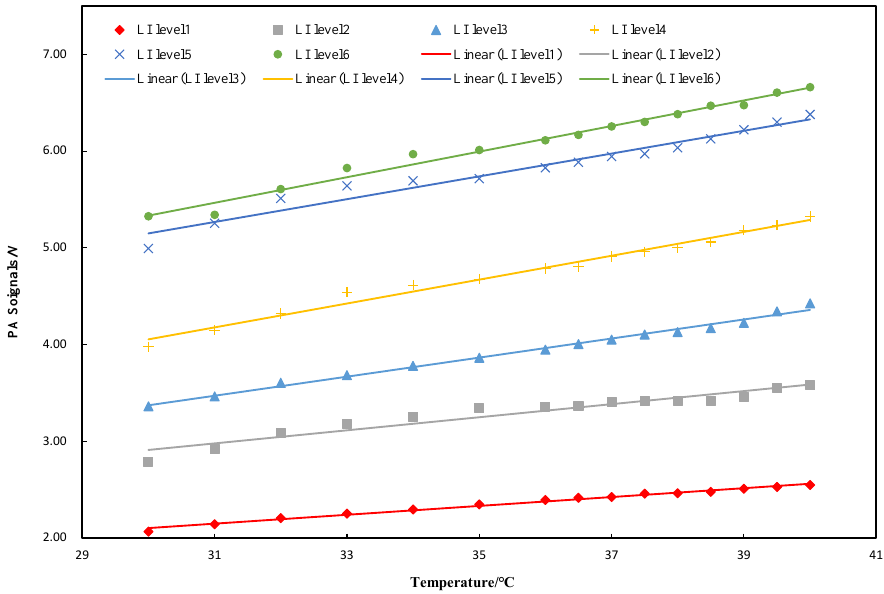
Figure 3. Relation of the PA signals to temperature at the different light intensities.